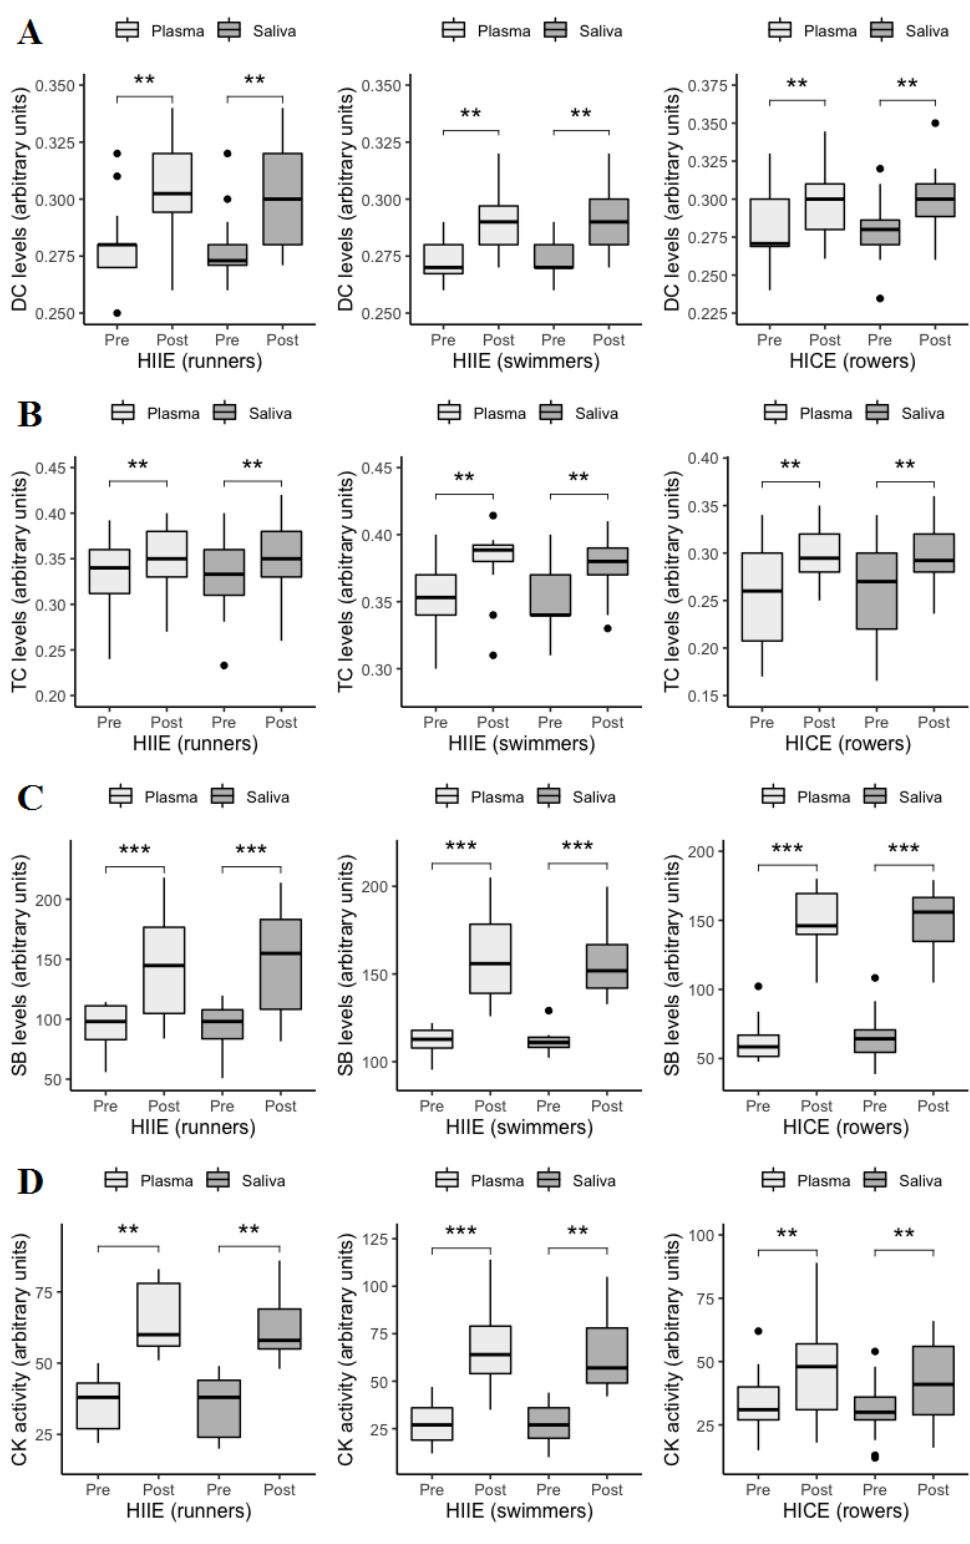
Figure 1. Plasmatic and salivary levels of DC ( A ), TC ( B ), SB ( C ), and CK ( D ) at pre-exercise and postexercise. Data are given as median and interquartile range and compared by Wilcoxon signed- rank test. n = 13 per group. ** p < 0.01. *** p < 0.001. DC: diene conjugates; TC: triene conjugates; SB: Schiff bases; CK: creatine kinase; HIIE: high-intensity interval exercise; HICE: high-intensity continuous exercise.